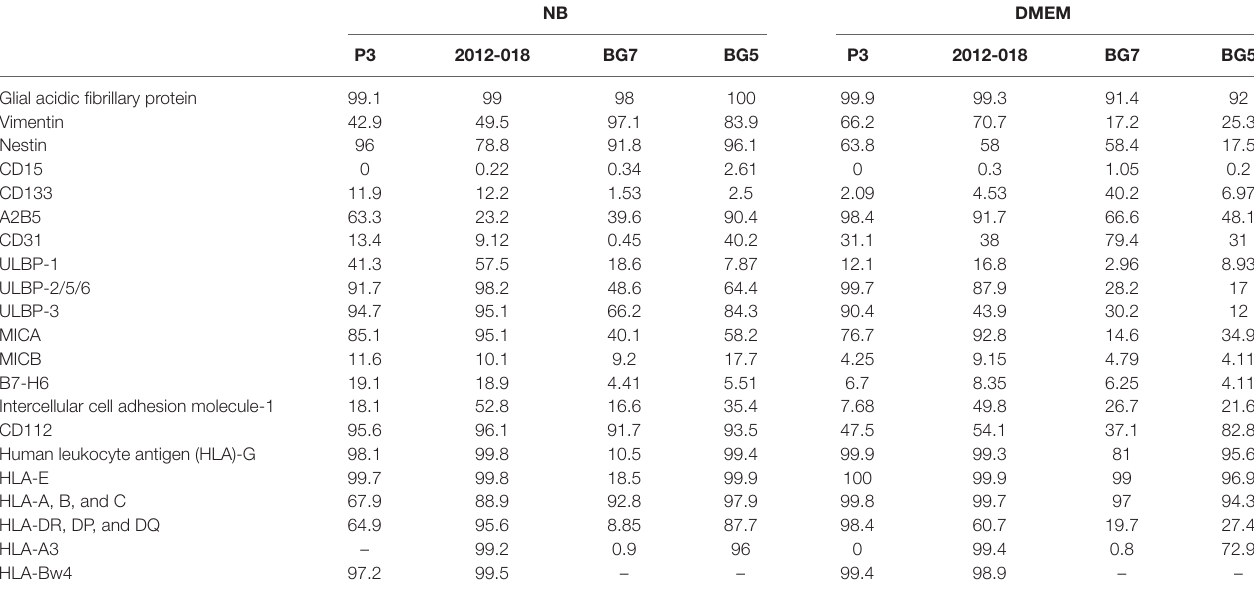
TaBle 1 | Phenotype of glioblastoma cells (% of cells expressing the markers) in NB and Dulbecco’s modified eagle medium (DMEM) media. nB DMeM